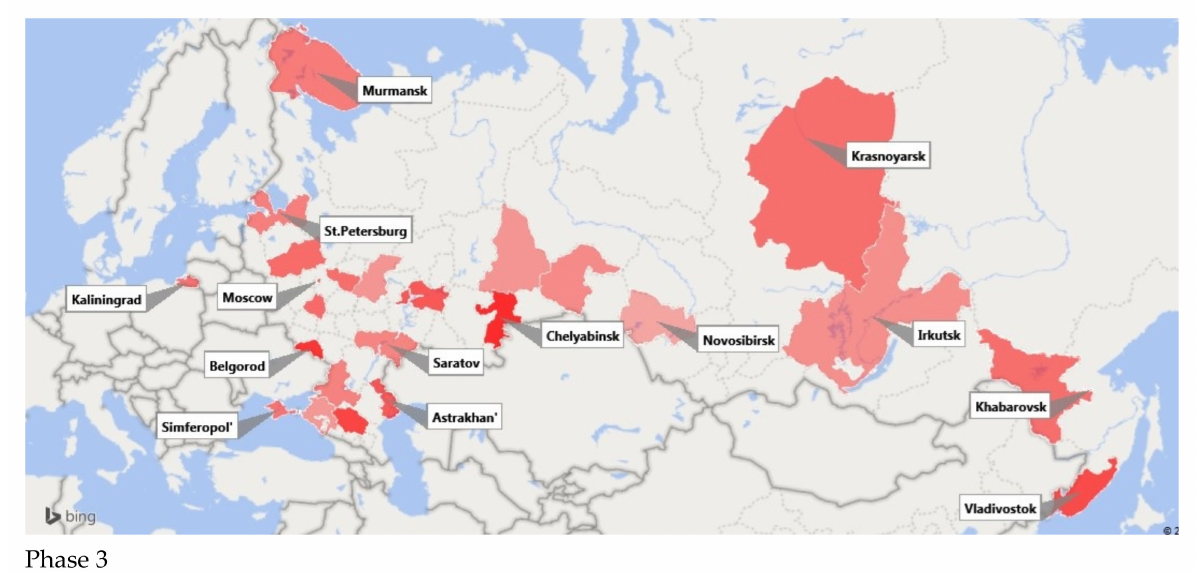
Figure 10. Color intensity representation of SARS-CoV-2 seroprevalence, Russian population, 2020. Phase 1—Seroprevalence levels in the first phase of monitoring (June–August). Phase 3—levels in the third phase (December). Color intensity reflects the percent seropositive: the more intense the color, the higher the level of population